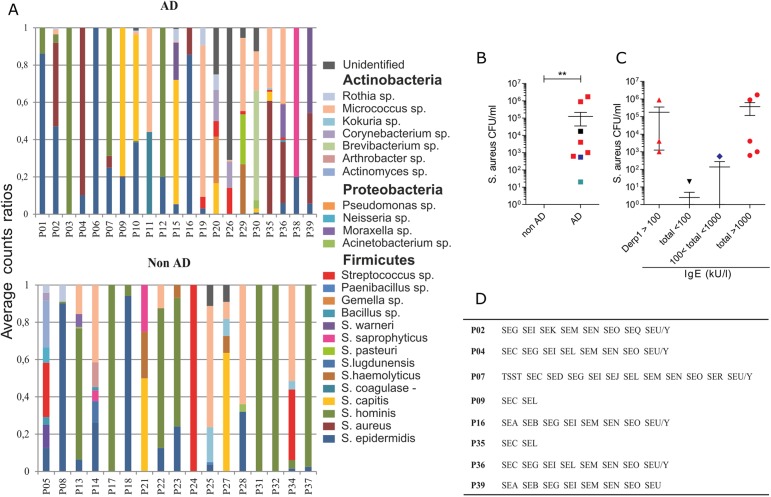

S. aureus was identified only in AD children and correlated with high IgE levels.(A) Ratios of average counts for bacterial species and their respective phyla found in the inflamed zones and control-matched zones of atopic dermatitis (AD) patients and their non-AD counterparts, respectively. (B) Colony-forming units (CFU/ml) of S. aureus from sampled zones in AD and non-AD subjects. Mann-Whitney, mean values with SEM are shown, p**<0.01. The black square denotes a patient with undetermined IgE values. (C) AD subjects were sorted in relation to the amounts of IgE antibodies (kU/l) measured in their blood. (B, C) Total IgE over 1000kU/l is shown in red, between 100 and 1000 kU/l in blue and below 100 kU/l in green. (D) Enterotoxins were identified in S. aureus clones from AD subjects (P02-P39) by DNA array.